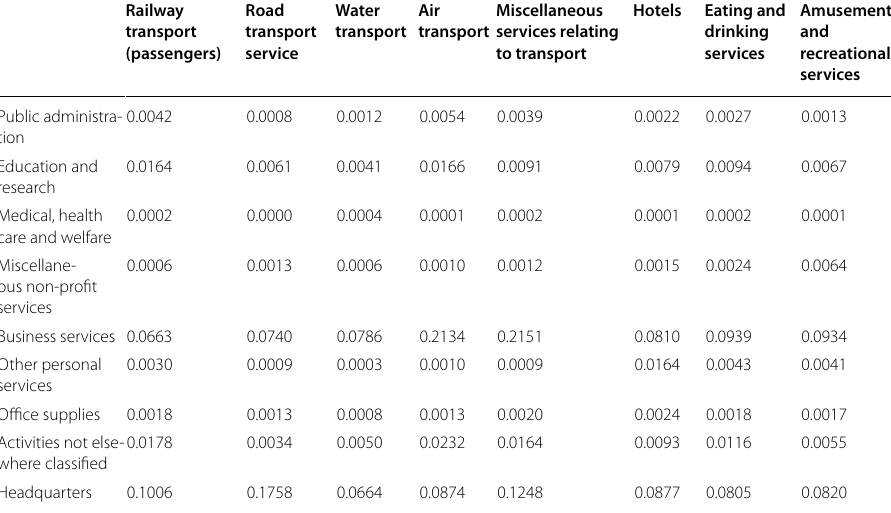
Table 5 Internal multiplier ( T ) and external multiplier ( K ) of tourism sector in Tokyo